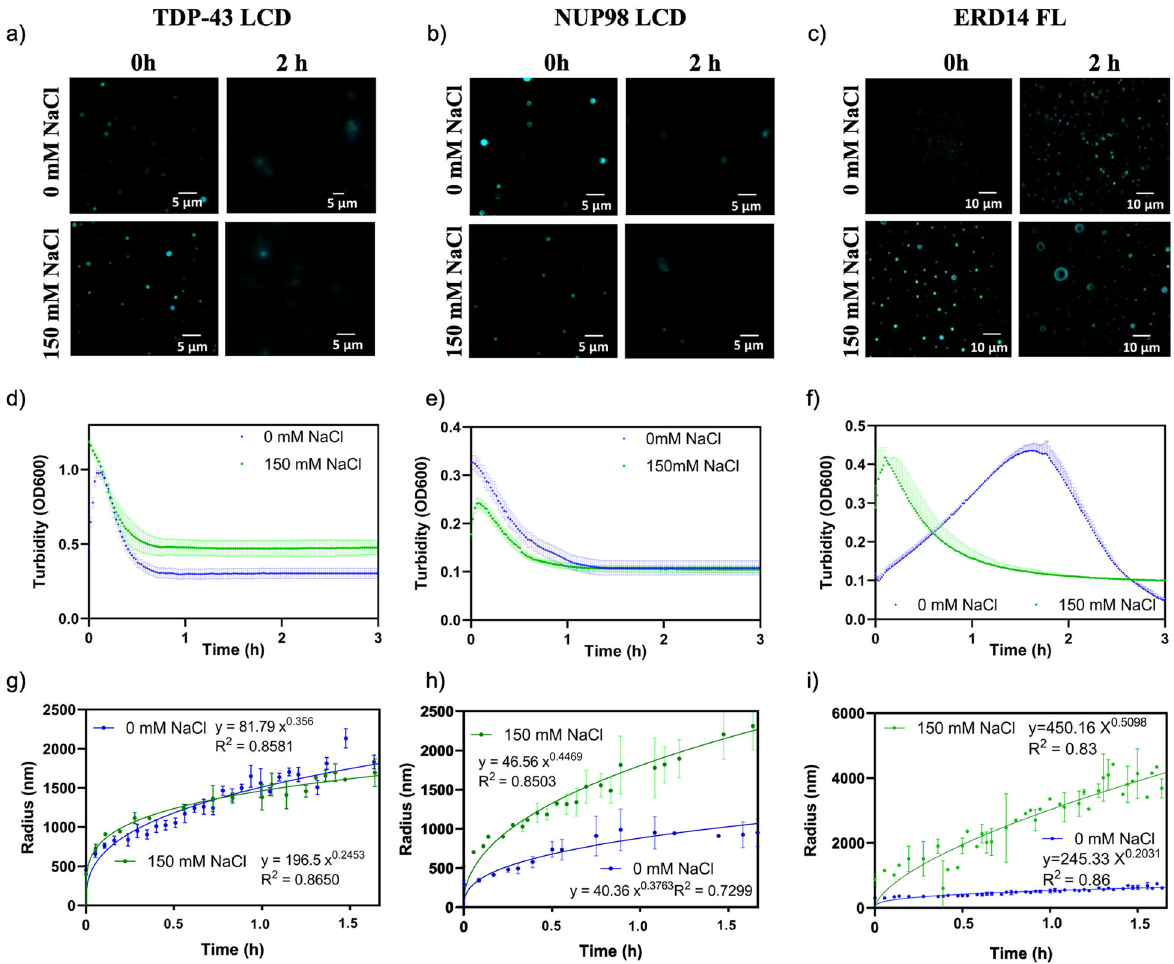
Fig. 2 Phase separation of three different proteins induced by the pH jump approach. LLPS of TDP-43 LCD ( a , d , and g ), NUP98 LCD ( b , e , and h ) and full-length ERD14 ( c , f , and i ) was induced by a pH jump from pH = 3.5 to 7.5 (TDP-43 LCD, at 80 μ M), pH = 3.0 to 7.5 (NUP98 LCD, at 10 μ M) and pH = 11.0 to 6.6 (ERD14, at 20 μ M in the presence of 1 mg/ml poly(U) and 8% PEG 6000). Droplets were visualized by fl uorescence microscopy of Dylight 488- labeled proteins (mixed into ×200 excess of non-labeled proteins, a , b , and c ) without and with salt (150 mM NaCl) immediately after initiating LLPS (marked 0 h) and after 2 h of incubation. LLPS was also monitored by turbidity (OD600) measurement ( d , e , and f ) in the absence of NaCl (blue lines) and in the presence of 150 mM NaCl (green lines). The size evolution of droplets formed upon LLPS was also followed by DLS ( g , h , and i ), in the absence of NaCl (blue lines), and in the presence of 150 mM NaCl (green lines, fi tting functions are also shown on panels). All kinetic traces are mean ± SD of experiments in triplicate ( n =